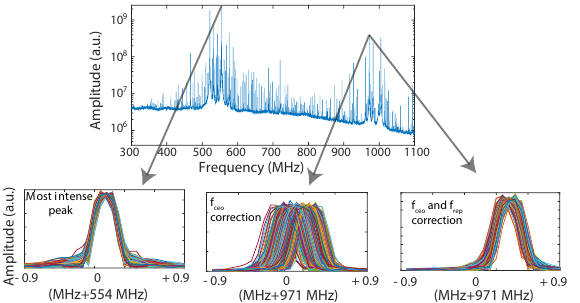
Figure 21: Baseline measurement of dual-comb spectrometer with both f ceo and f rep corrections. Data acquisition time is